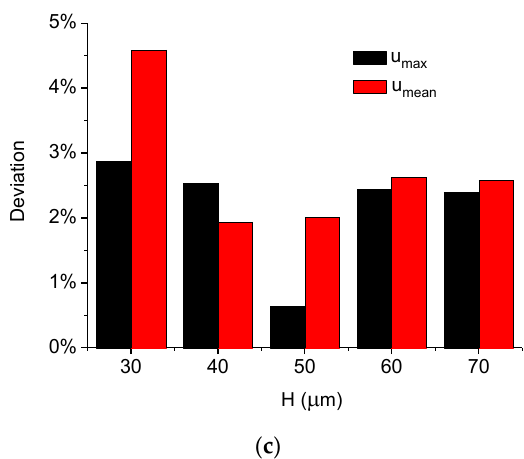
Figure 7. ( a ) Computed acoustic streaming velocity distribution along the r direction at the droplet-substrate interface in the ultrasonic probe-droplet-substrate system under different H . ( b ) u max , u mean and SRD versus H in the ultrasonic probe-droplet-substrate system. ( c ) Deviations of u max and u mean computed by the PM and RSM versus H in the ultrasonic probe-droplet-substrate system. The dependency of acoustic streaming velocity on the radius of the MMP R is shown in Figure at the droplet-substrate interface computed by the PM and RSM under di ff erent R . Figure 8b shows u max , u mean and experimentally measured SRD of the cleaned area for yeast cells and SiNPs versus R , from which it is seen that both u max and u mean increase with the increase of R , which results in that the SRD increases with the increase of R . This result indicates that the removal e ff ect of micro / nanoscale particles can be controlled by using MMPs with di ff erent radii. Figure 8c shows D of u max and D of u mean versus R , respectively, and it is seen that D of u max is in the range of 0.6% to 2.8%, while D of u mean is in the range of 1.6% to 3.5%.